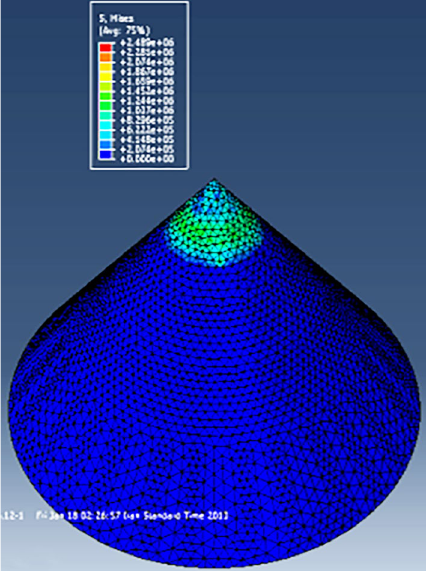
Fig. 14. Von misses composite stress contour in conical building while explosion strikes building at height of 6 meters above the ground